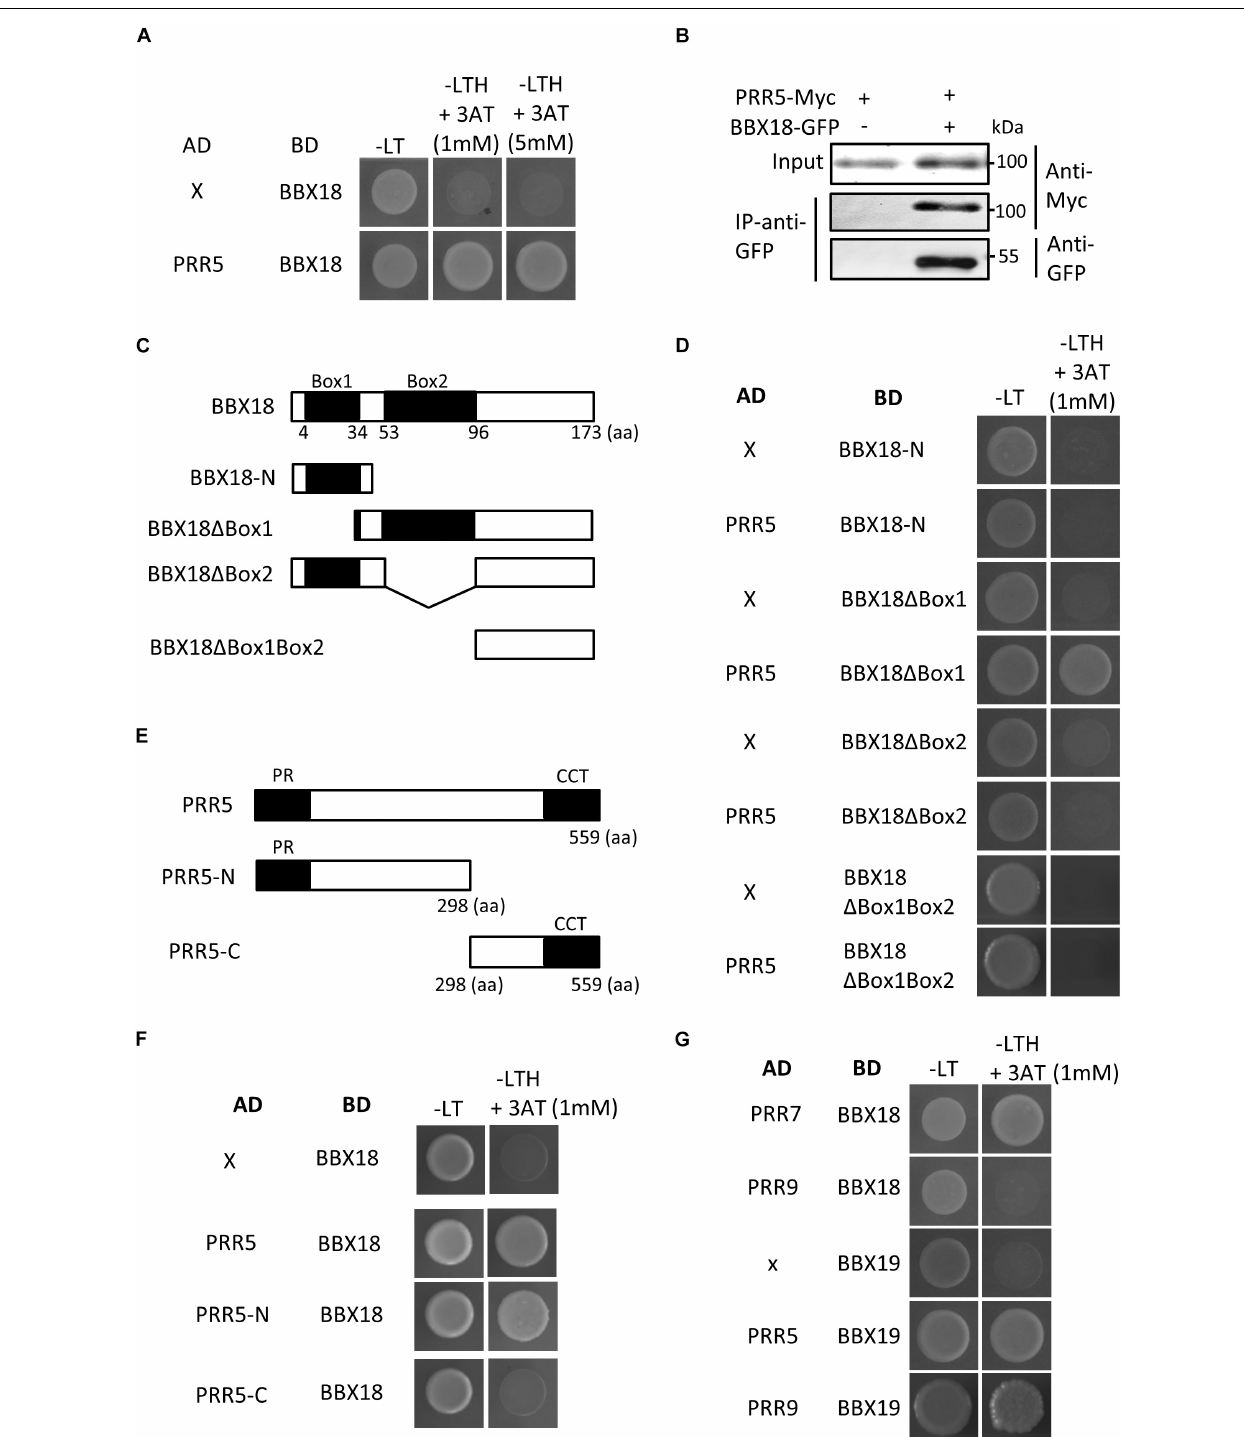
FIGURE 4 | BBX18 interacts with PRR proteins, including PRR5. (A,D,F,G) Yeast two-hybrid assays showing the BBXs interacting with PRRs. Yeast clones were grown on synthetic dropout media lacking Leu and Trp (-LT) and lacking Leu, Trp, and His (-LTH), but containing various concentrations of 3-amino-1,2,4-Triazole (3-AT). (B) BBX18 interacted with PRR5 in planta . Protein extracts from protoplasts expressing PRR5-Myc and PRR5-Myc and BBX18-GFP were immunoprecipitated using the anti-GFP antibody and analyzed by immunoblotting with the anti-GFP and anti-Myc antibody, respectively. The molecular weight (kDa) is indicated on the right side of the gel. (C) Box diagram depicting various BBX18 fragments used in the yeast two-hybrid assays in (D) . (E) Box diagram depicting various PRR5 fragments used in the yeast two-hybrid assays in (F) .